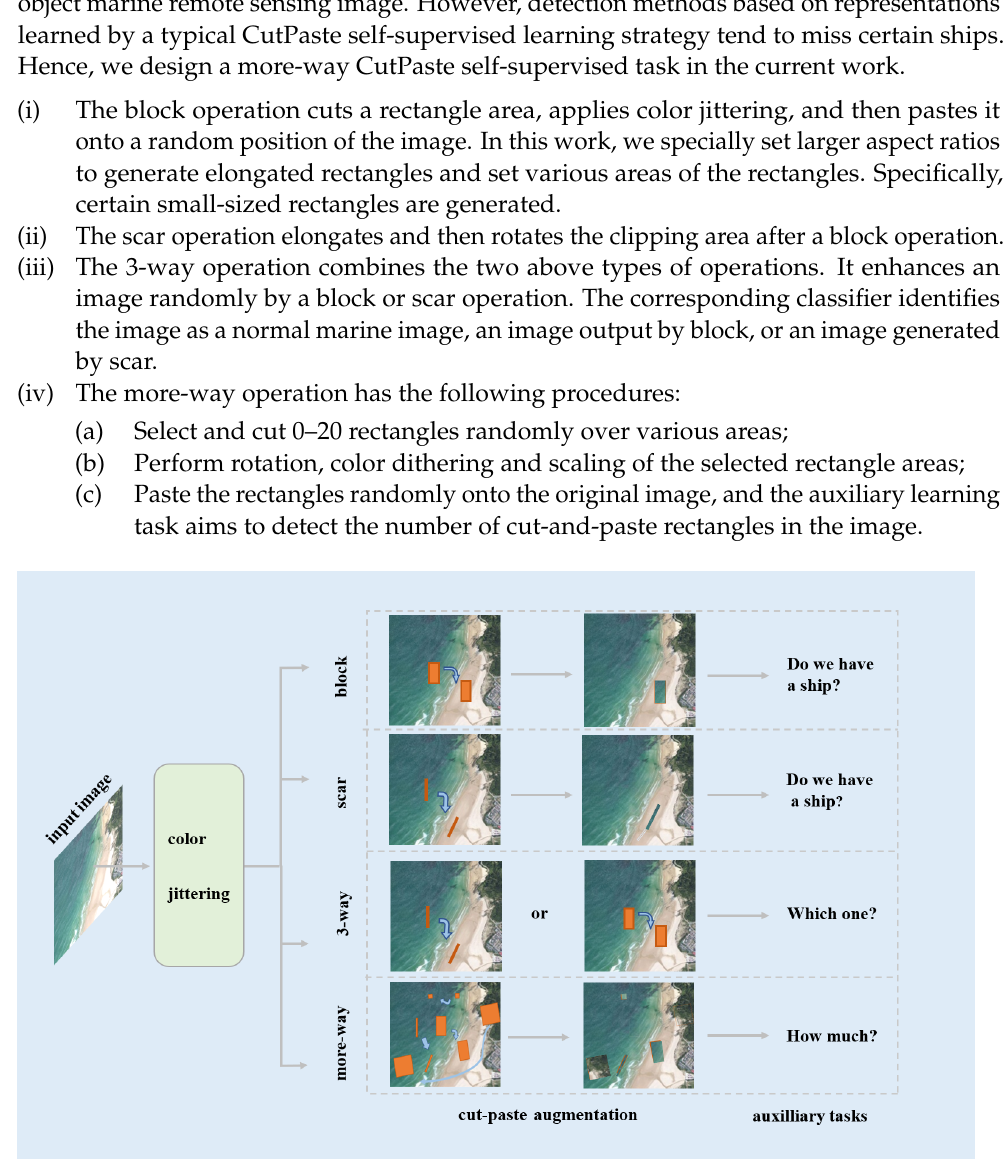
Figure 2. The CutPaste self-supervised tasks. After color jittering, the input image is subjected to various cut and paste operations, and the feature representation network is trained by auxiliary classification tasks. The more-way CutPaste operation is specially designed in this